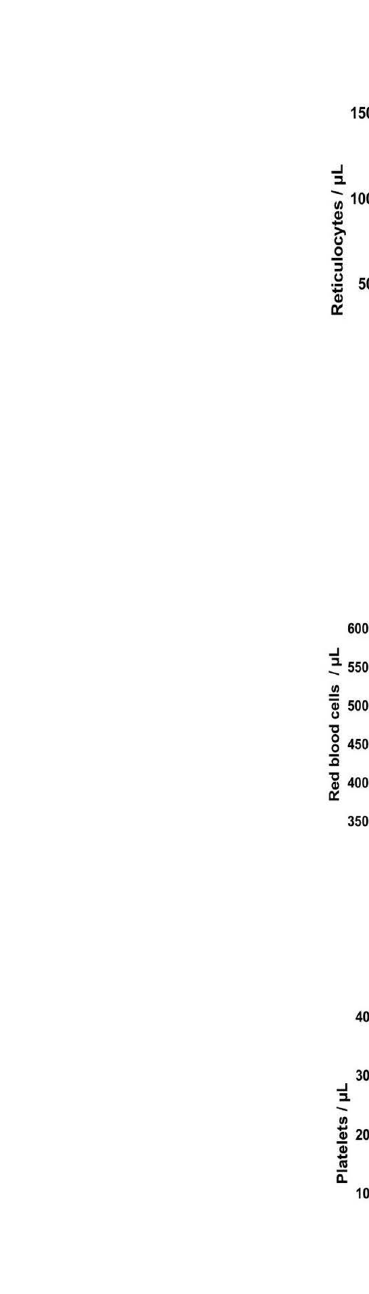
FIGURE 2 | Evolution of reticulocytes (n = 20), erythrocytes (n = 20) and platelets (n = 19) in the blood of volunteers before (BDC), during (HDT) and 13 days (R+13) after the end of bed rest. As no statistically signi fi cant differences between the control and cocktail groups were observed, individuals of both groups were pooled. Horizontal bars indicate the median. Statistically signi fi cant differences were revealed using either one-way ANOVA or a linear mixed effects model analysis. **p < 0.01; ***p < 0.001, ****p <